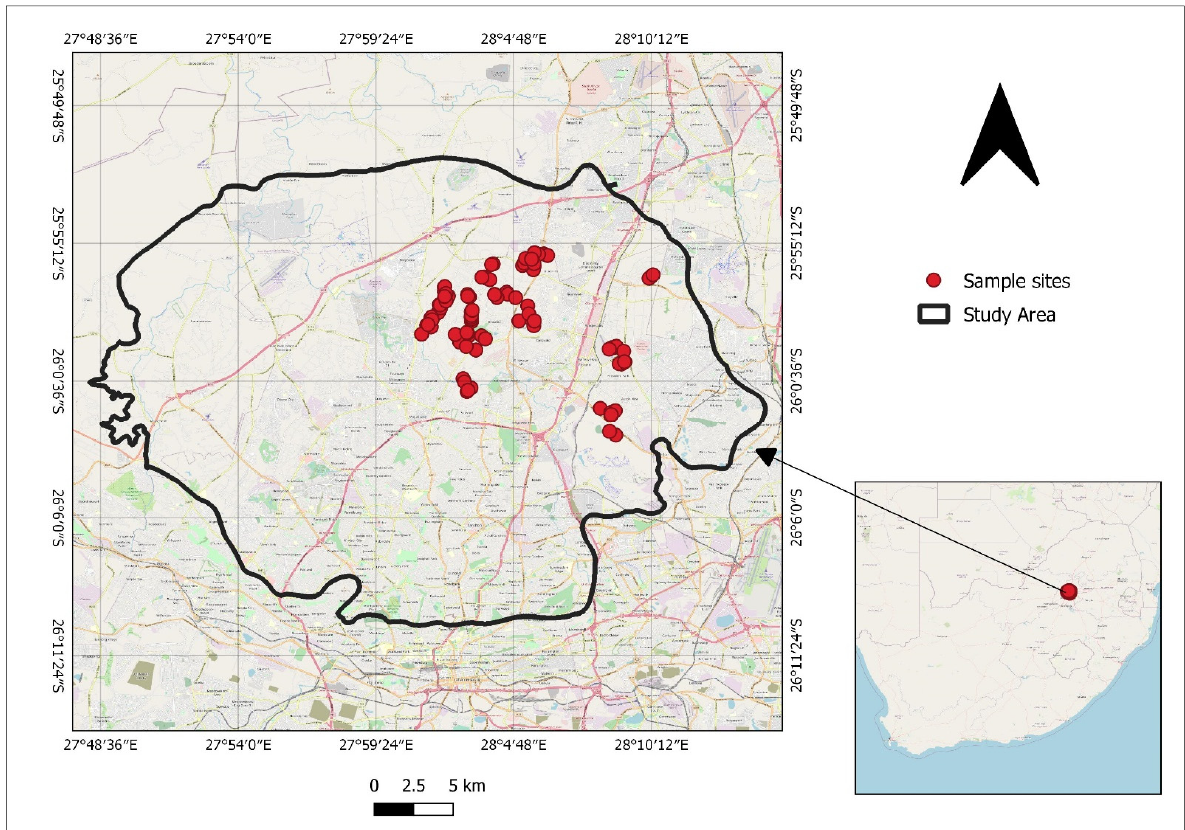
Figure 1. Location of the sampling sites within Johannesburg Granite Dome.